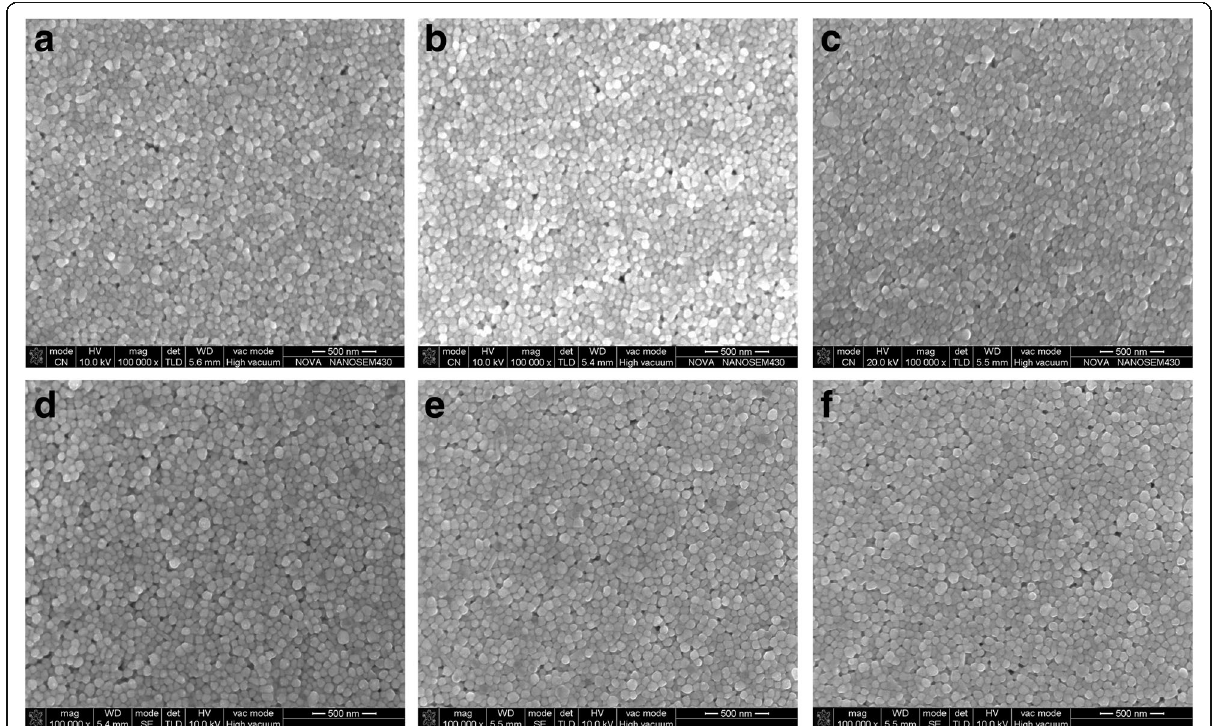
Fig. 4 SEM images of silver films UV-cured at ( a ) D = 37 cm for 180 s; ( b ) D = 37 cm for 300 s; ( c ) D = 37 cm for 480 s; ( d ) D = 29 cm for 180 s; ( e ) D = 25 cm for 180 s; ( f ) D = 25 cm for 480